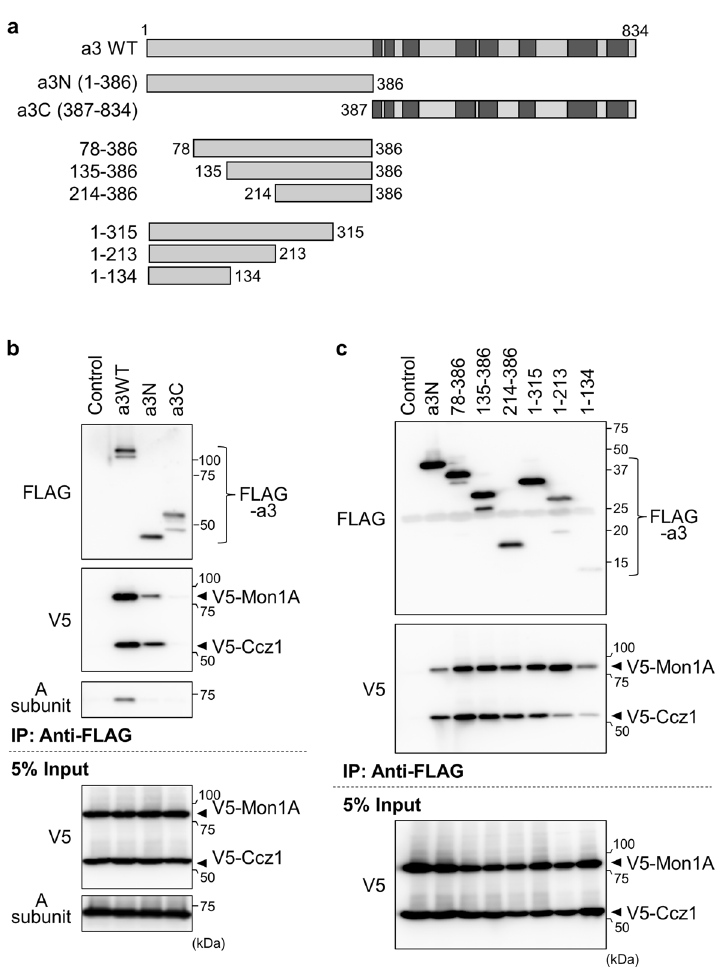
Figure 3. Identification of the a3 domain involved in the interaction with Mon1A-Ccz1. ( a ) Structures of a3 deletion mutants. The structures of a3 deletion mutants are schematically illustrated. a3N and a3C represent the cytosolic amino-terminal half of a3 and the carboxy-terminal half with eight transmembrane domains (dark gray), respectively. Numbers indicate amino acids from the amino terminus. ( b , c ) Interaction between a3 deletion mutants and Mon1A-Ccz1. FLAG-tagged halves of a3 ( b ) or FLAG-tagged deletion mutants of a3N ( c ) were co-expressed with V5-Mon1A and V5-Ccz1 in HEK293T cells. Immunoprecipitation using anti-FLAG antibody and western blotting were performed as described in Fig. 1. FLAG-a3 derivatives were not expressed in control experiments (Control). Unprocessed scans of immunoblots in ( b ) and ( c ) are shown in Supplementary Fig. S5